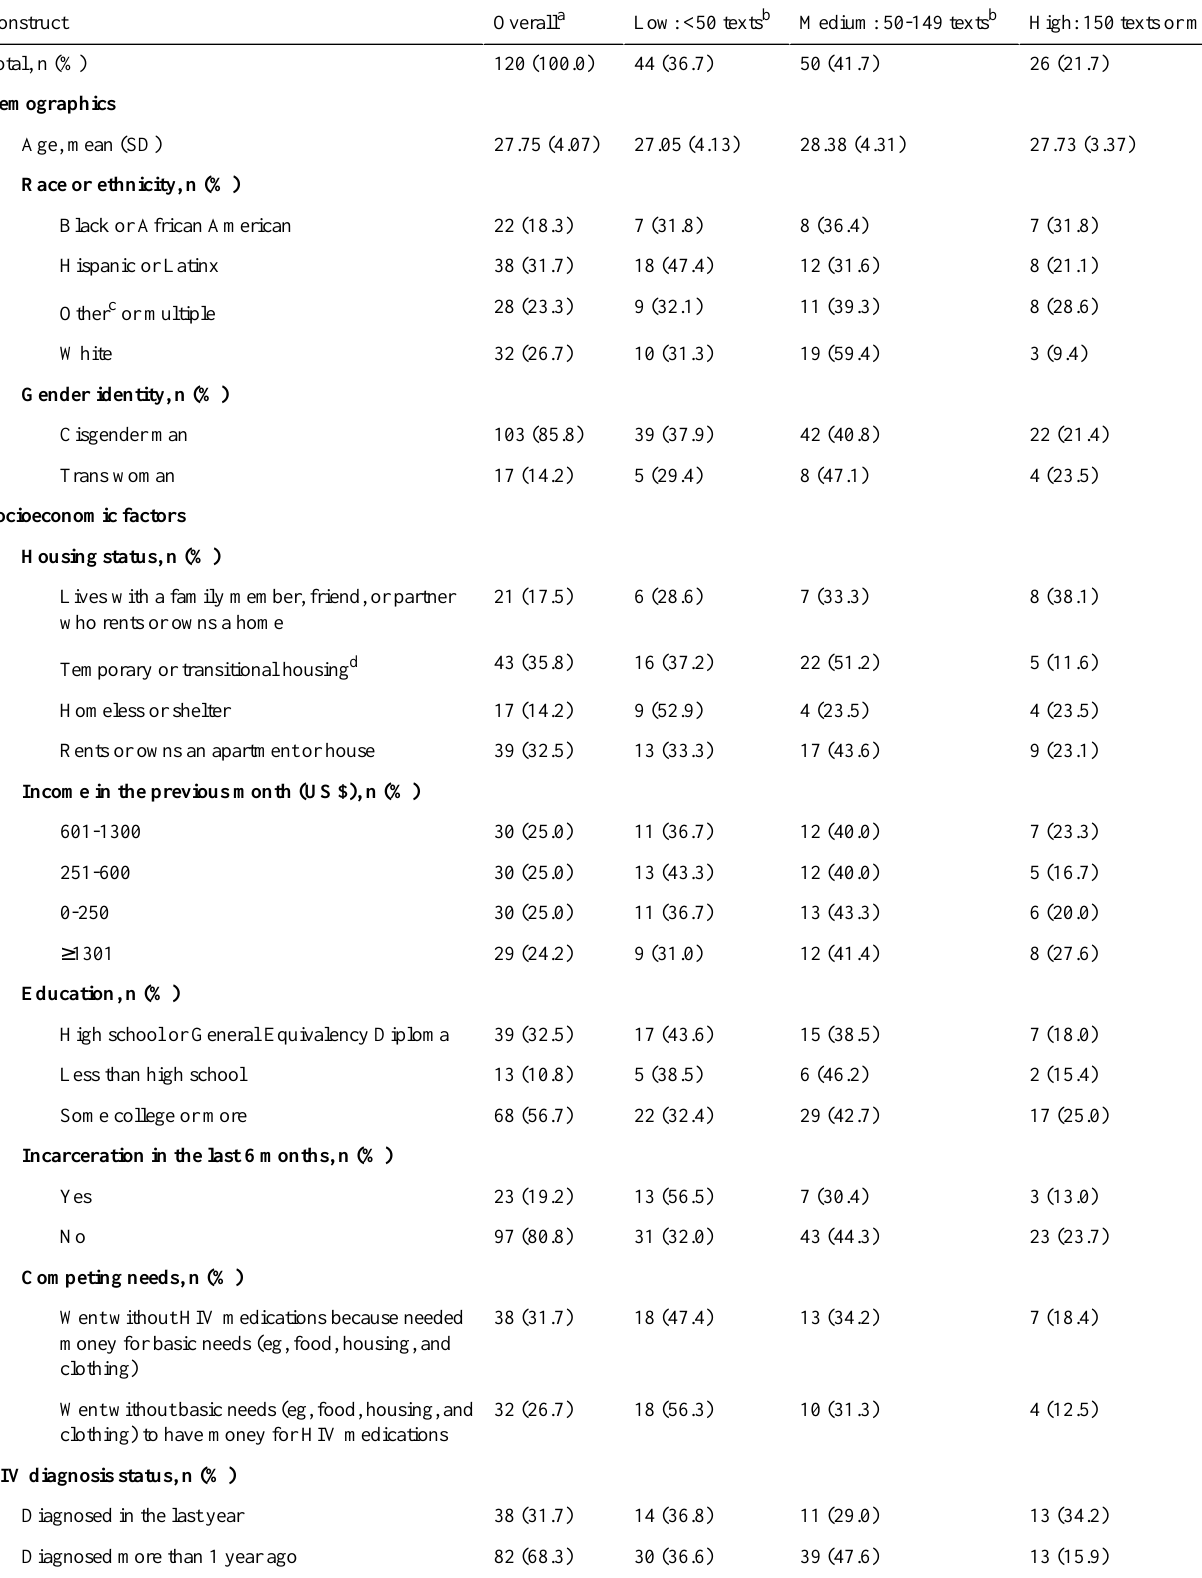
Table 1. Sample characteristics, overall and by engagement level over the 6-month study period, Health eNavigation, 2017-2018 (N=120).